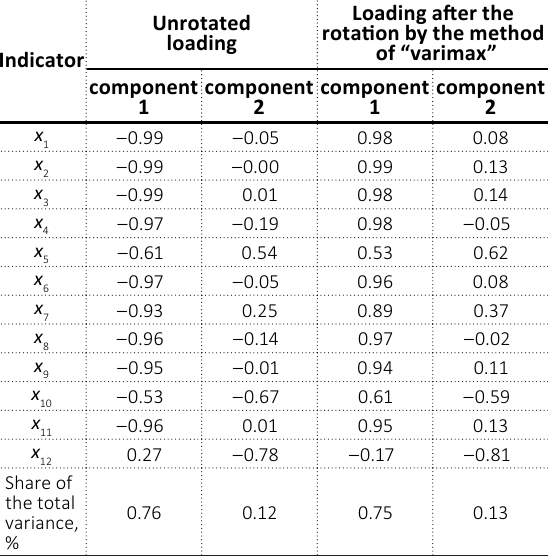
Table 6. Factor loading on the main components